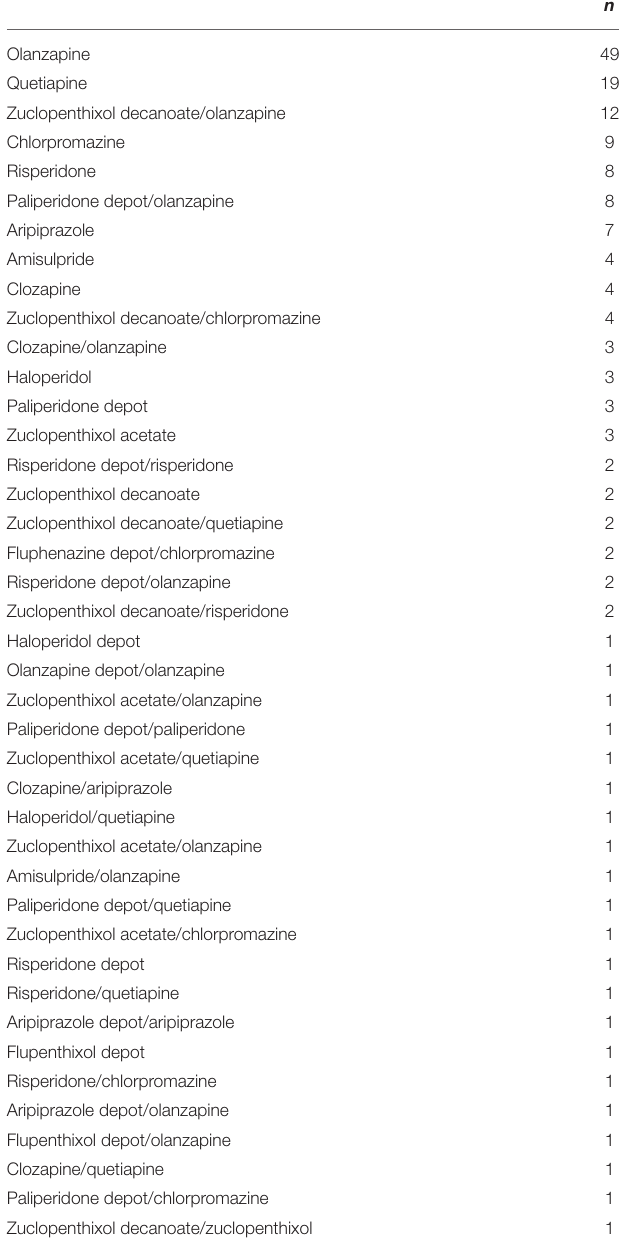
TABLE 2 | Antipsychotic medication status at admission in acute psychosis patient